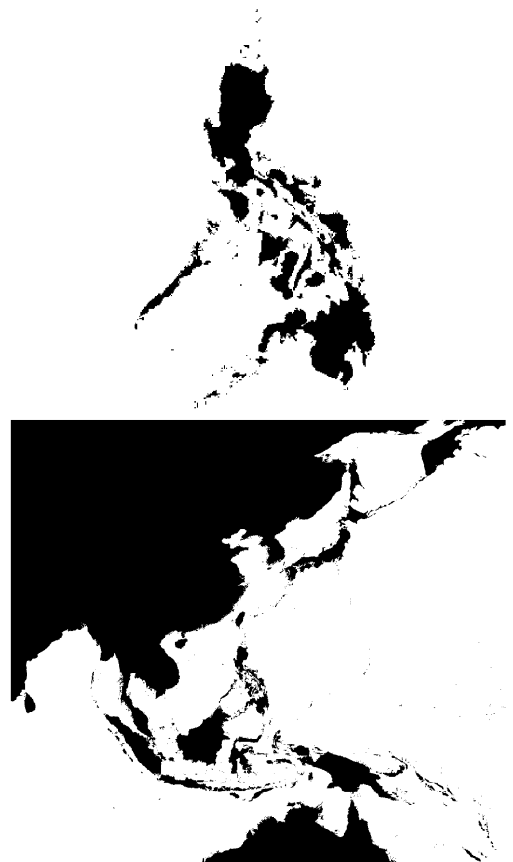
Figure 1. Scope of the study (top: Philippines, bottom: vicinity of the Philippines) 3.2